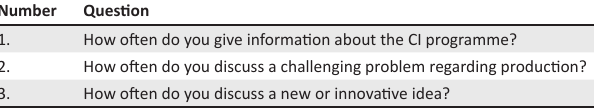
TABLE 3: Organisational network analysis measurements per organisational network analysis question used to generate organisational network analysis graphs. TABLE 2: List of organisational network analysis